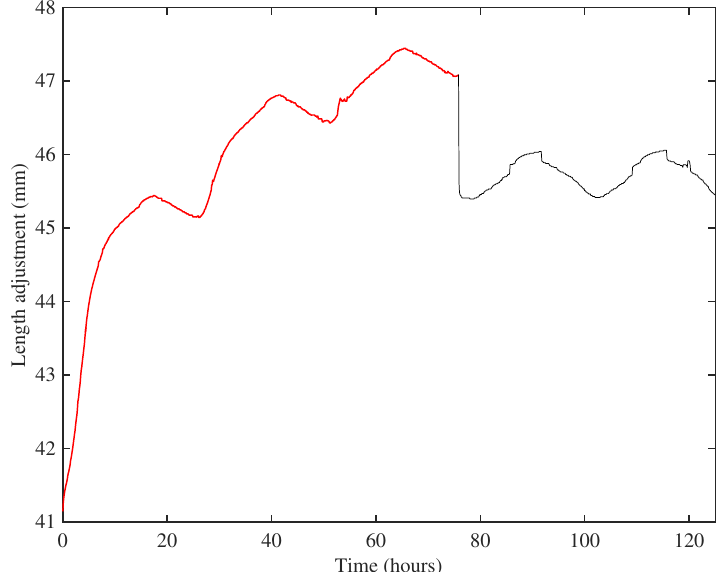
Figure 2. The length adjustment response for String 8 (A6) during the creep settling for the step between 375 Hz and 403 Hz. The string was over-tuned to 427 Hz for about 72 h (red) before being tuned back down to its target frequency of 403 Hz